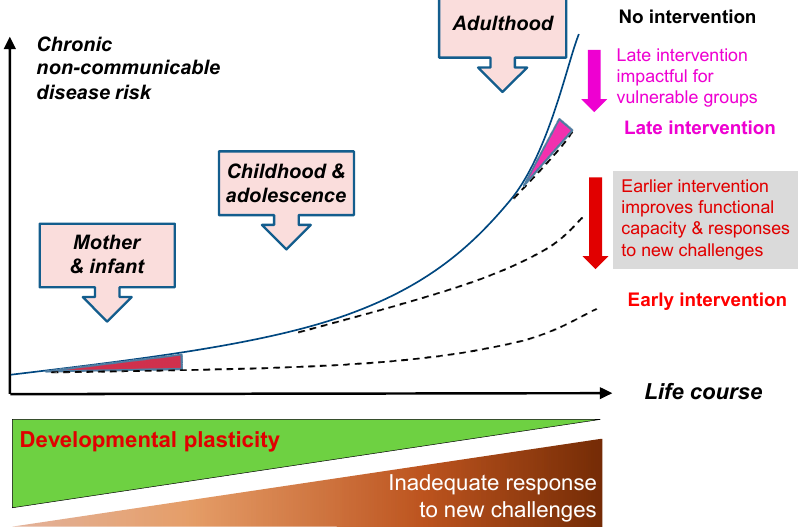
Figure 1. Timing of interventions and effect on disease risk. Reprinted from Hanson et al. [3] with permission.